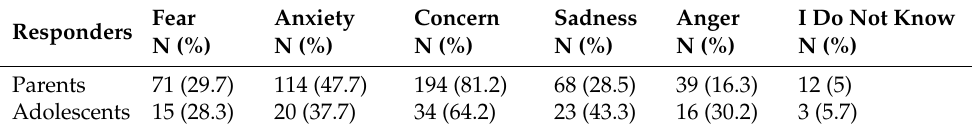
Table 5. Feelings evoked in parents and adolescents when thinking about